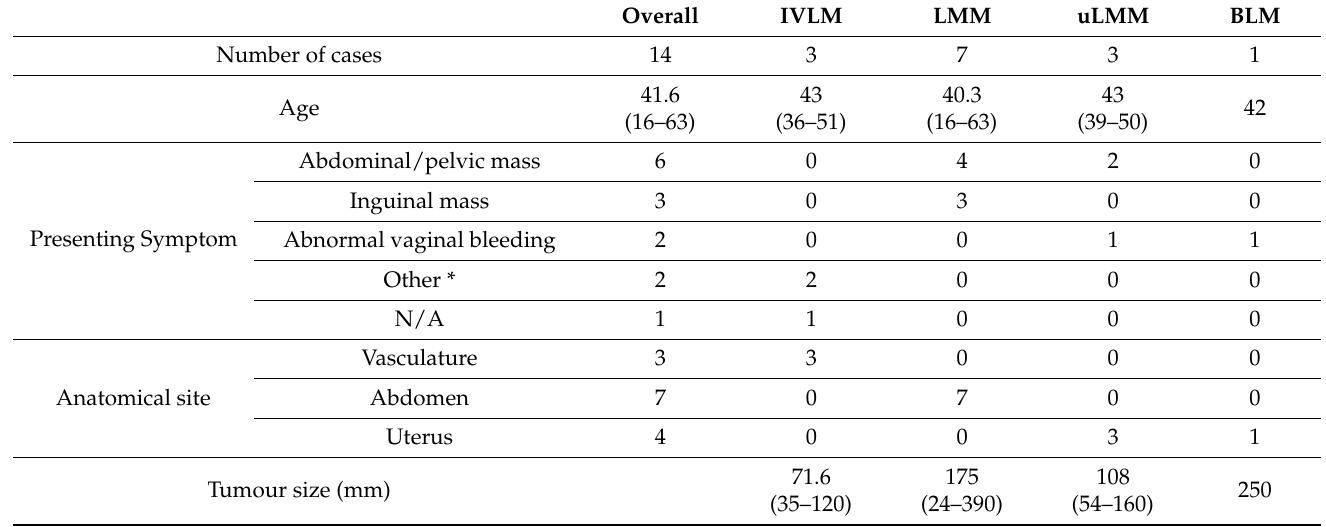
Table 1. Clinico-pathological characteristics of the